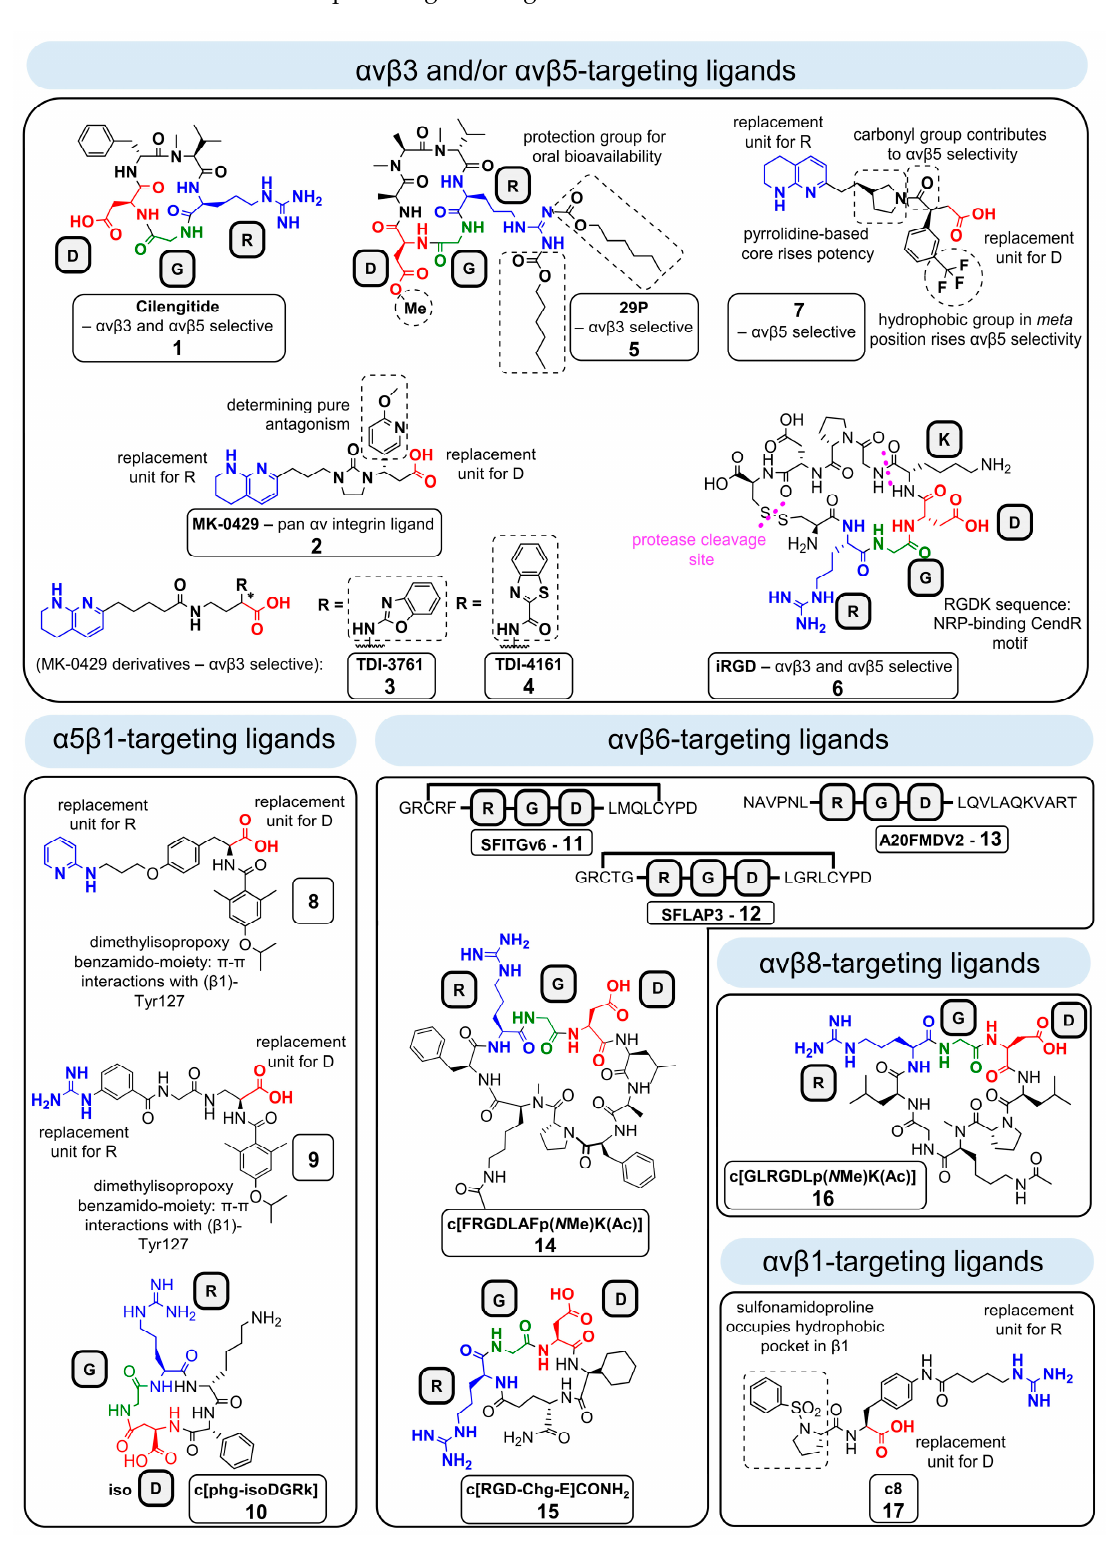
Figure 7. Overview of all described integrin targeting ligands. Within this review, only RGD targeting integrin ligands were described. Hereby, integrins α v β 3, α v β 5, α 5 β 1, α v β 6, α v β 8, and α v β 1, respectively, represent the most important targets for cancer therapy and imaging. phg = D -phenylglycine, Chg = L -cyclohexylglycine, Ac = acetyl, N Me = N- methylated.